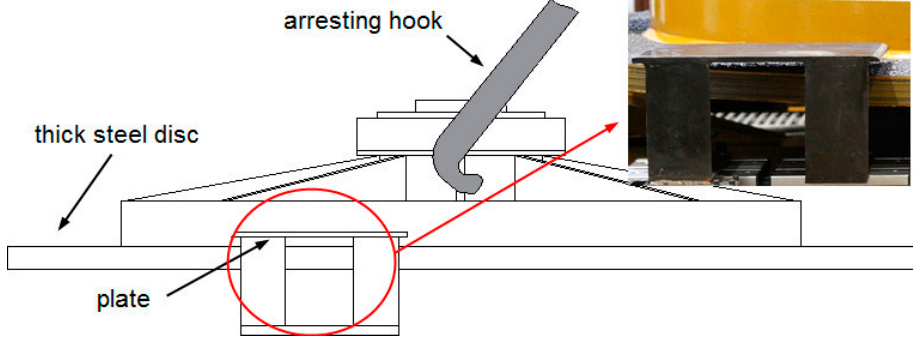
Figure 9. Design rendering and material object of disc.